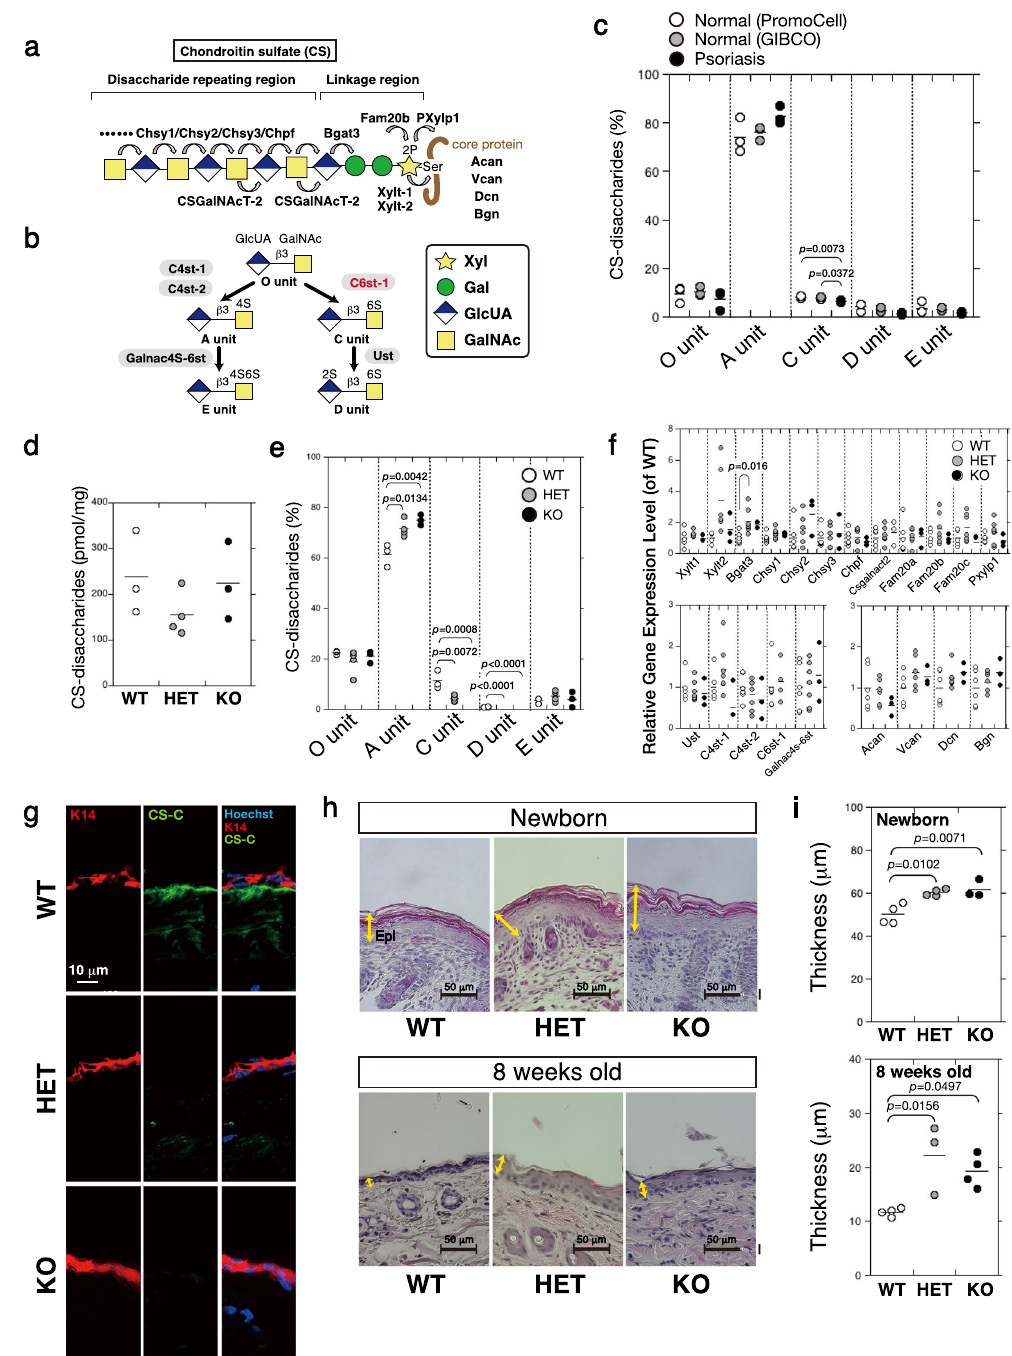
Fig. 1 Downregulation of chondroitin 6-sulfate is associated with epidermal hyperplasia. a The structure of CS chains is mediated by various glycosyltransferases. The common glycosaminoglycan – protein linkage region, GlcUA β 1 – 3Gal β 1 – 3Gal β 1 – 4Xyl β 1-, is built on speci fi c serine (Ser) residue(s) of core proteins such as ACAN, VCAN, DCN, and BGN. After the linkage region is formed, the CS polymerase complex assembles the CS backbone (disaccharide repeating region). b Outline of sulfation pathways. The C6-position of the GalNAc residue in the O unit is sulfated by C6ST-1 to form the C unit. Subsequently, the C unit is converted to a D unit by uronyl 2- O -sulfotransferase UST. c Expression of CS chains in normal human skin fi broblasts ( n = 3) and psoriatic fi broblasts ( n = 3) was analyzed using high pressure liquid chromatography (HPLC) to measure the composition of CS-disaccharides. Sulfated CS chains, isolated from the epidermis of C6st-1 WT ( n = 3), C6st-1 HE ( n = 4), and C6st-1 KO mice ( n = 3), were analyzed using HPLC to measure the total amount ( d ) and composition of CS-disaccharides ( e ). f Gene expression levels of CS biosynthetic enzymes in the epidermis of C6st-1 WT ( n = 4-6), C6st-1 HE ( n = 4-7), and C6st-1 KO mice ( n = 3) were analyzed using real-time PCR. g The expression pattern of 6- O -sulfated CS (CS-C) in the tail epidermis of C6st-1 WT, C6st-1 HE, and C6st-1 KO adult mice was examined by immunohistochemical analysis using anti-keratin 14 (K14) and anti-CS-C antibody. h Hematoxylin-eosin staining of paraf fi n-embedded skin samples from newborn and 8-week-old C6st-1 WT, C6st-1 HE, and C6st-1 KO mouse skin. Yellow arrows indicate epidermis. i Epidermal thickness of newborn and 8-week-old C6st-1 WT, C6st-1 HE, and C6st-1 KO mice. Newborn mice, C6st-1 WT ( n = 4), C6st-1 HE ( n = 4), and C6st-1 KO ( n = 3) ; 8-week-old mice, C6st-1 WT ( n = 4), C6st-1 HE ( n = 3), and C6st-1 KO ( n = 4) . Statistical signi fi cance was determined using one-way ANOVA with Tukey ’ s HSD test. COMMUNICATIONS BIOLOGY| (2021) 4:114 |https://doi.org/10.1038/s42003-020-01618-5|www.nature.com/commsbio